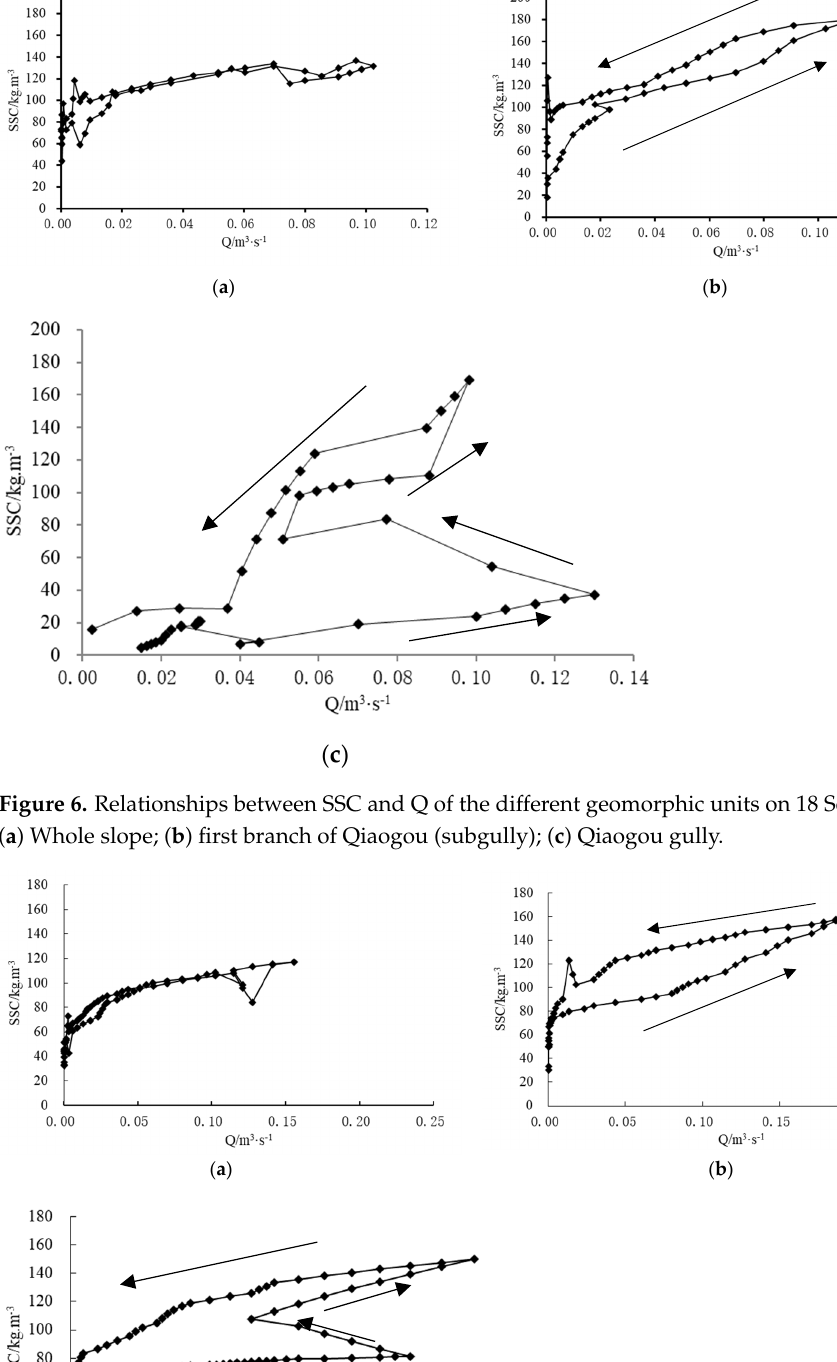
Figure 5. Rainfall spatial distribution on 18 September 2008 and 19 July 2009 in the Qiaogou water- shed: ( a ) 18 September 2008; ( b ) 19 July 2009 .